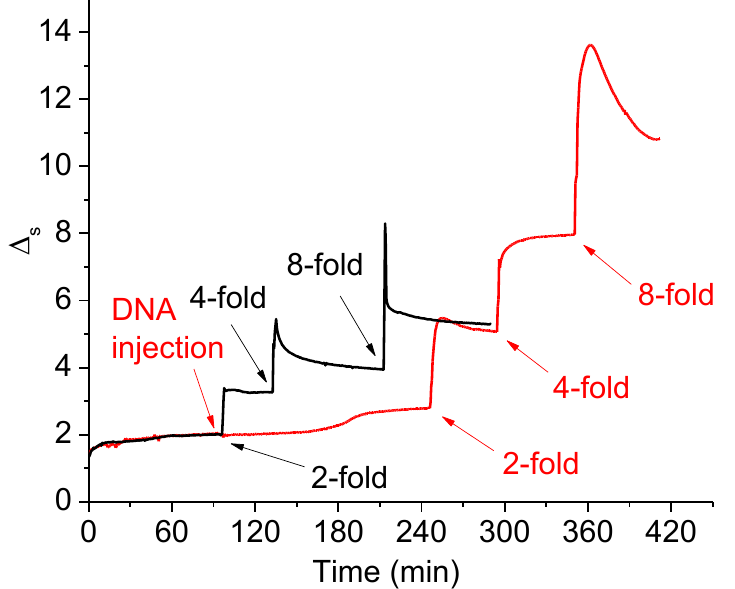
Figure 4. Kinetic dependencies of the ellipsometric angle Δs without (black line) and with (red line) DNA injection into the subphase. Arrows indicate the subsequent surface compressions and DNA injection. The total DNA concentration is 50 μM.